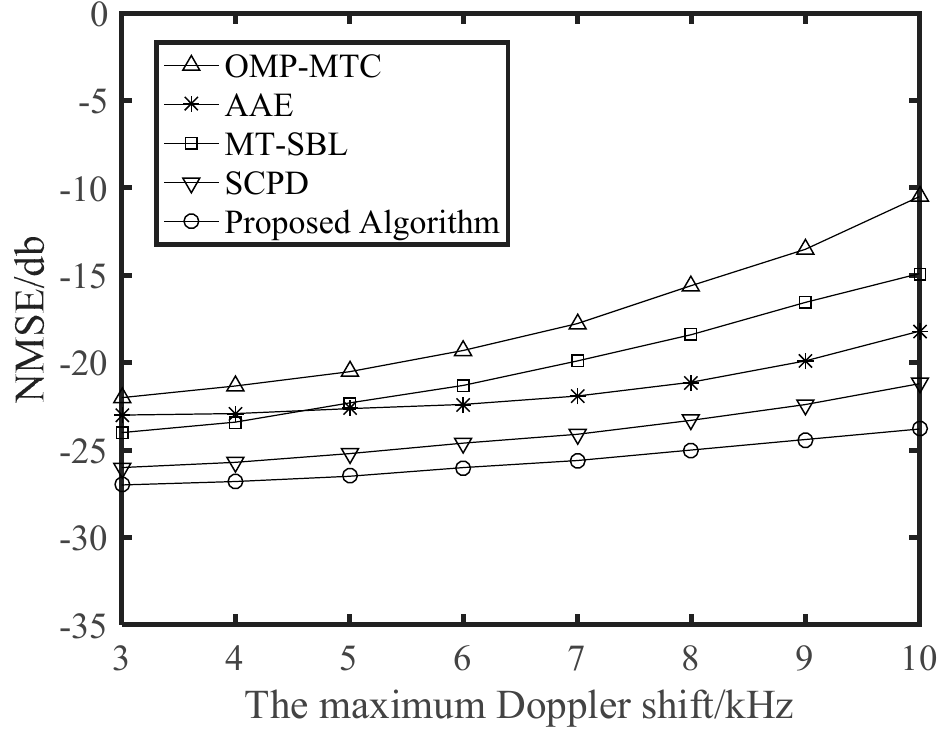
Figure 4. NMSE performance against the maximum Doppler shift with G T = 128, G R = 32, SNR = 20 dB, N R = 16, and N T = 64 antennas. The number of vehicles is 4, and the distance between vehicles is greater than 50 m.